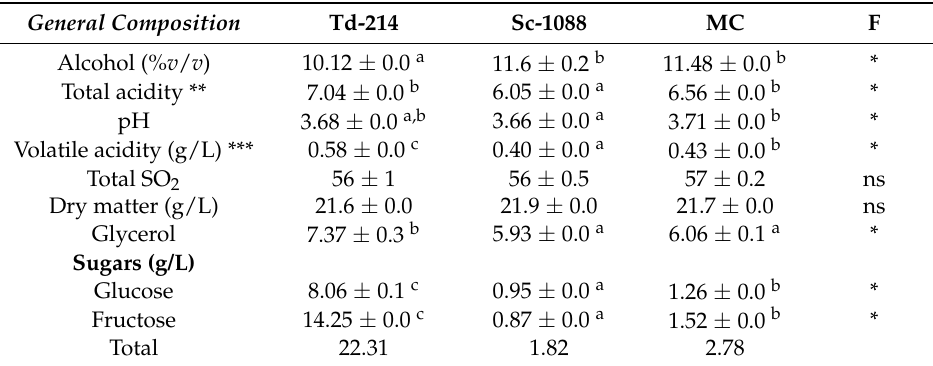
Table 1. General compositions of Narince